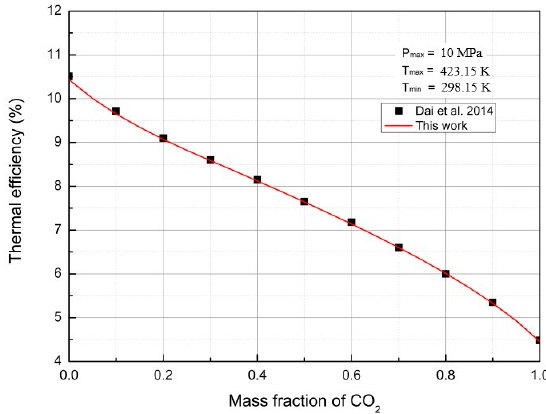
ffi ciencies for CO